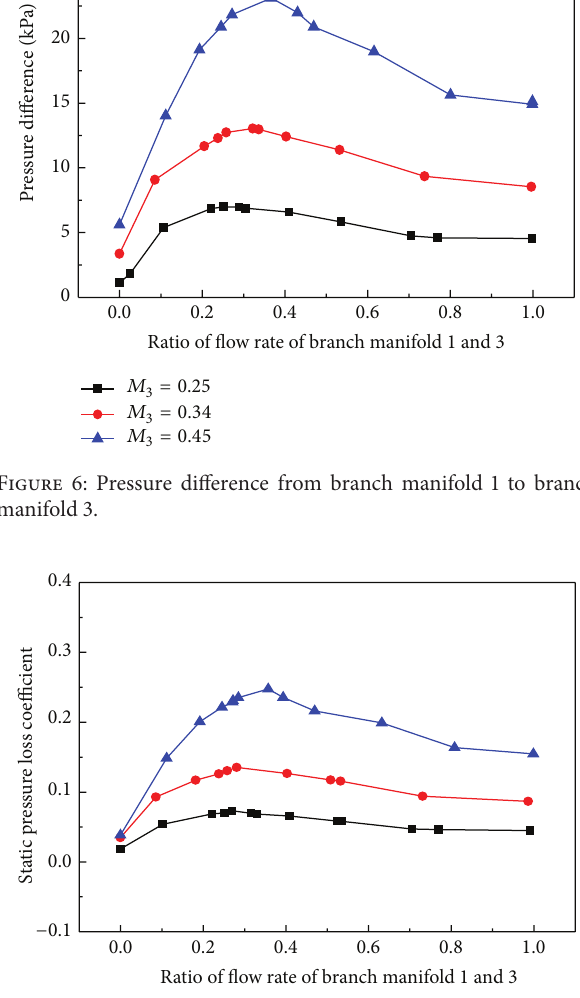
Figure 7: Static pressure loss coefficient from branch manifold 1 to branch manifold 3.